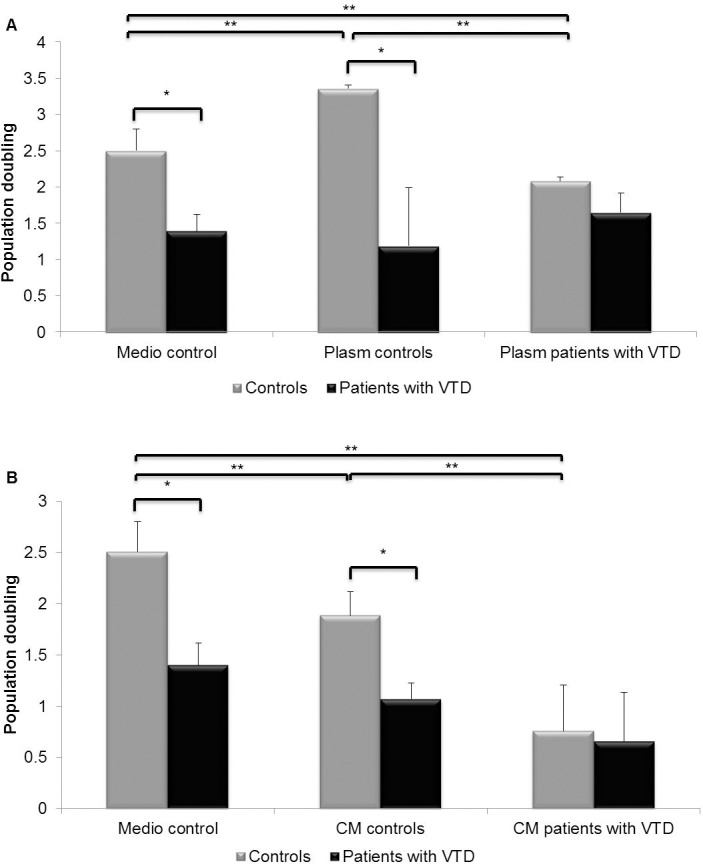
Effect of plasma and supernatants on the proliferative potential of ECFC-ECs obtained from peripheral blood of controls and patients with VTD.(A) The figure shows the number of ECFC-ECs in controls and patients with VTD at passage 4 after stimulation with plasma obtained from controls and patients with VTD. (B) Results of the 24-h incubation of supernatants and ECFC-ECs from VTD patients and controls. Results are expressed as mean ± standard deviation of three independent experiments, *P ≤0.05, **P ≤0.05.